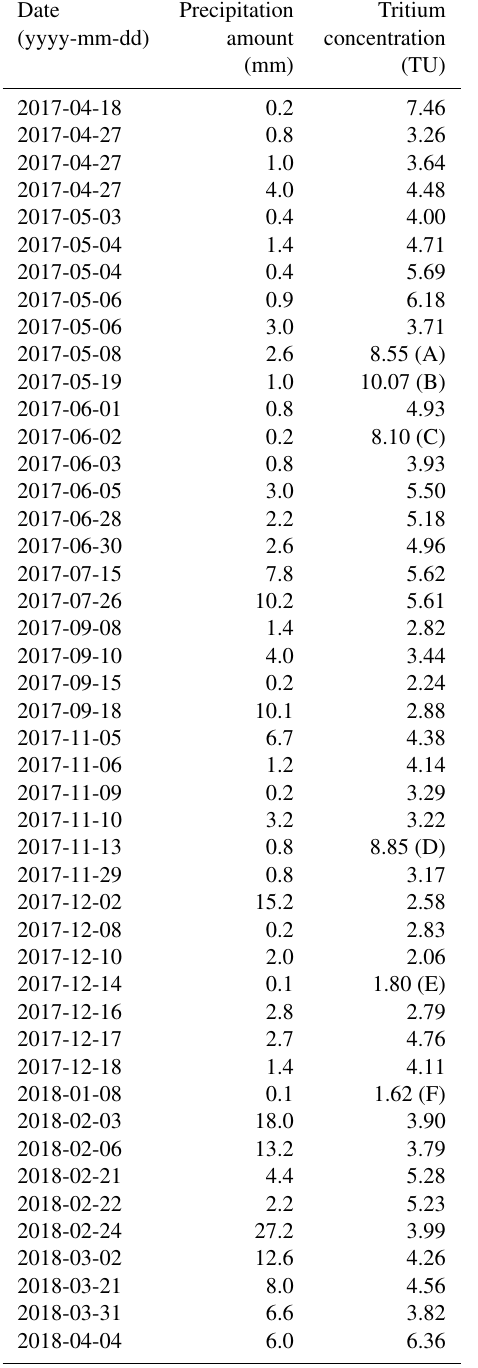
Table 1. Precipitation amount and tritium concentration values for all of the measured precipitation event samples. The letters follow- ing the tritium concentration refer to the discussion of outlier values in Sect. 4.3.